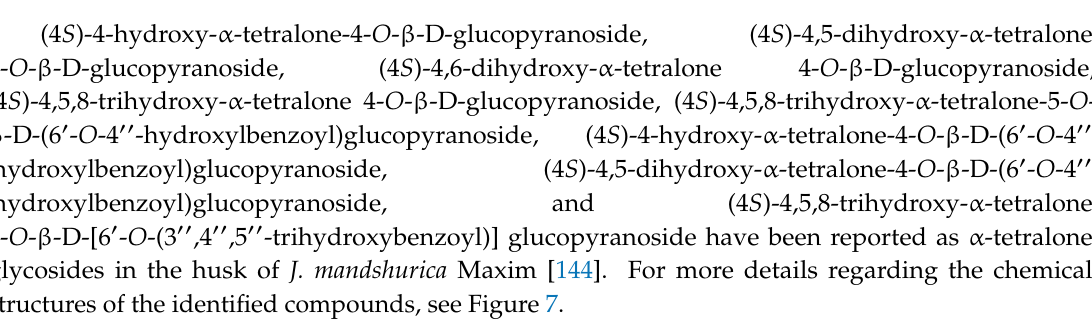
Figure 6. The chemical structures of di ff erent identified, isolated, and quantified α -tetralones and α -tetralone dimers in the walnut green husk.